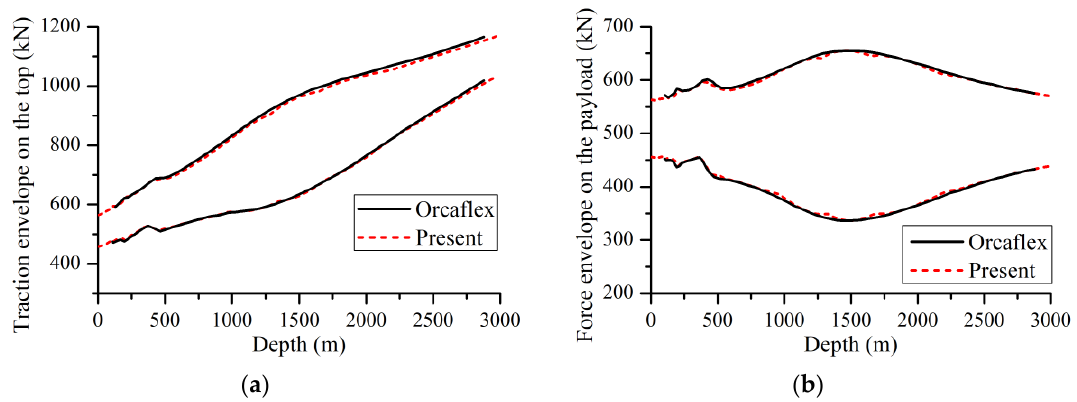
Figure 6. Traction envelopes under the sinusoidal crane tip excitation ( H s = 0.3 m, T s = 9 s) with a payout speed of 0.2 m/s: ( a ) at the top of the cable, ( b ) on the equipment.